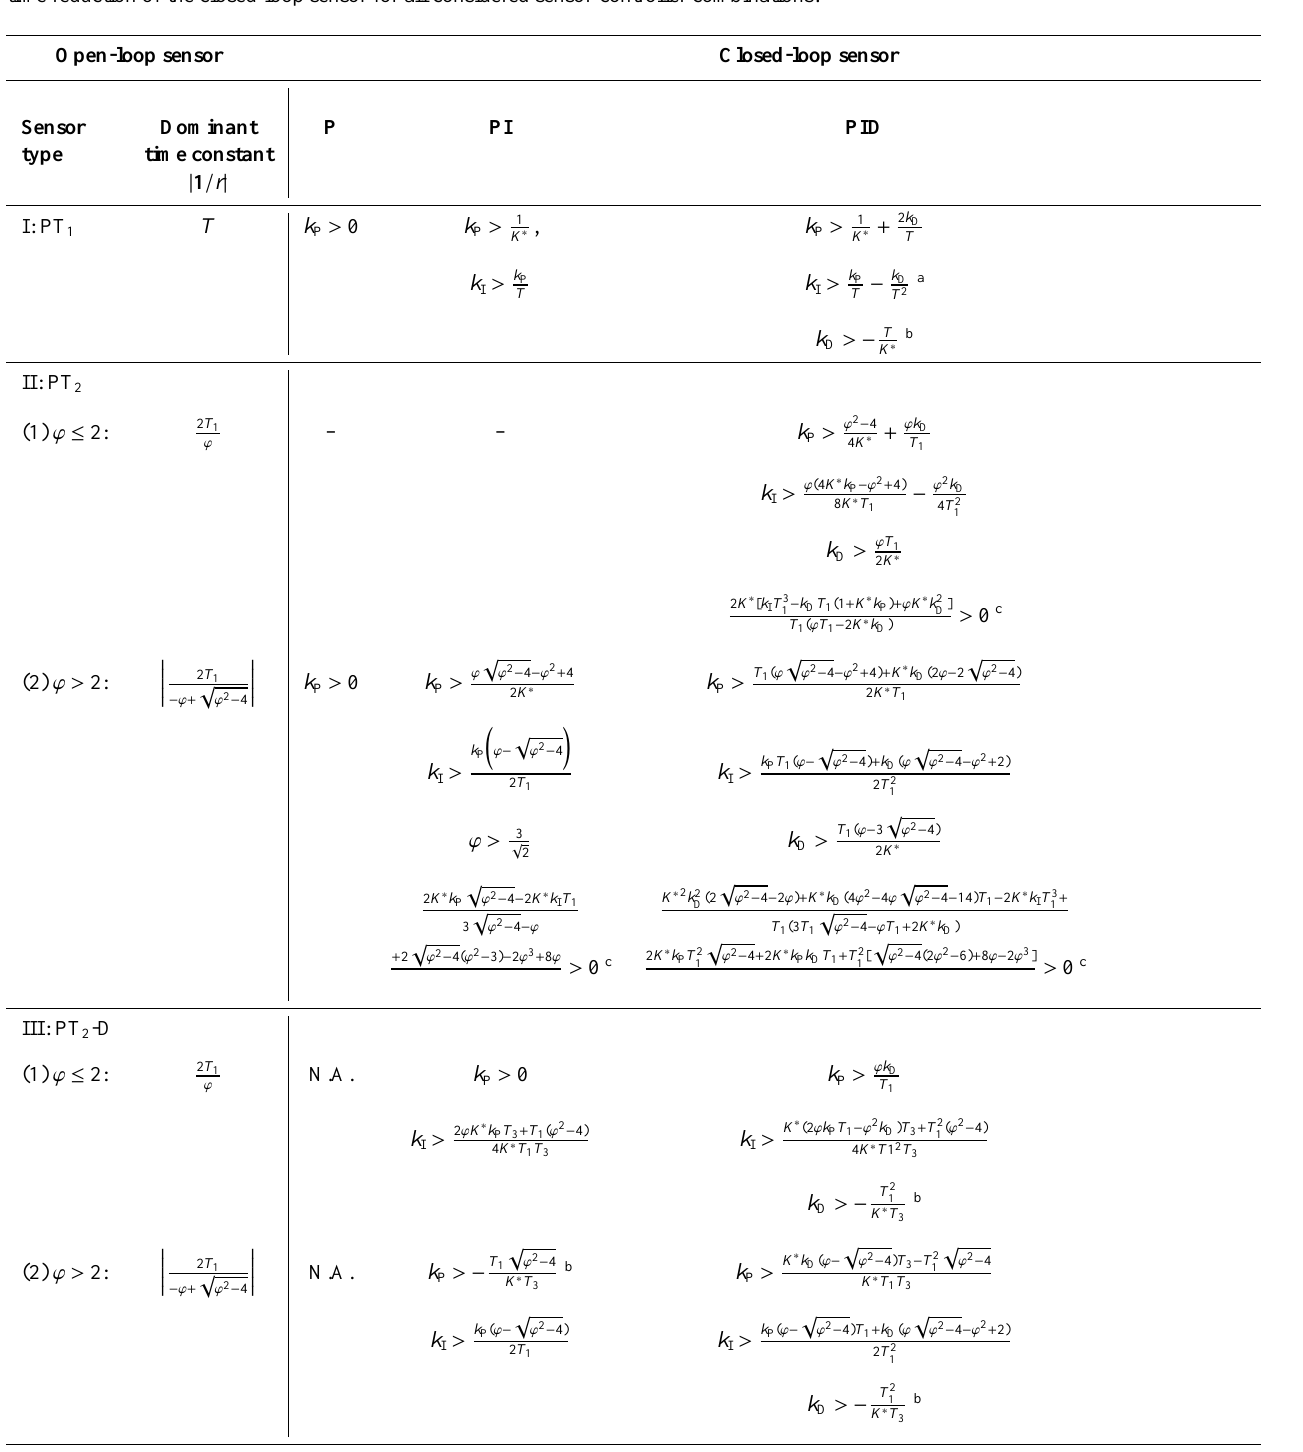
Table 10. Dominant time constants ( | 1 / r | ) of the three di ff erent sensor types as well as the requirements (parameter range) for a response time reduction of the closed-loop sensor for all considered sensor-controller